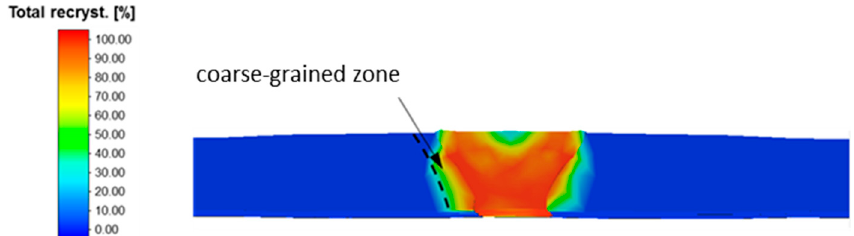
Figure 24. Fraction of total recrystallization after WeldForming with Inline-Plasma treatment.